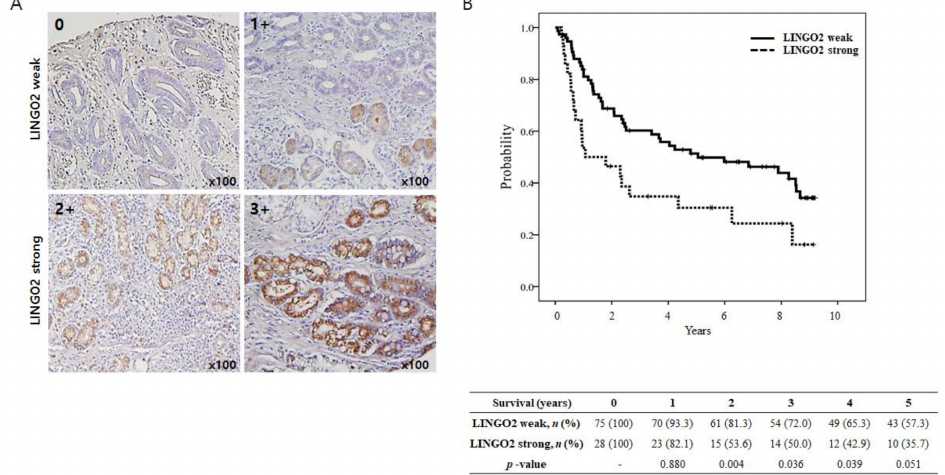
Figure 5. Kaplan-Meier estimates of overall survival (OS) according to LINGO2 expression. ( A ) LINGO2 expression in human gastric cancer tissues by immunohistochemistry. Tissue microarray samples of 103 gastric cancer tissues were stained with anti-LINGO2 antibody. LINGO2 staining was scored as a percentage of LINGO2-positive (+) tumor cells: no expression: 0, <20%: 1+, 20–50%: 2+, and >50%: 3+. 0 or 1+ was considered as LINGO2 weak whereas 2 or 3+ IHC staining scores of LINGO2 was considered LINGO2 strong group. ( B ) LINGO2 strong versus LINGO2 weak groups ( n , 75 versus 28): median, O.S.; 121.2 versus 25.5 months; p = 0.012 by log-rank test. Yearly survival rate after surgery was significantly lower in LINGO2 strong group. ( p = 0.004, 0.036 and 0.051 at 2, 3, and 5 years after surgery,